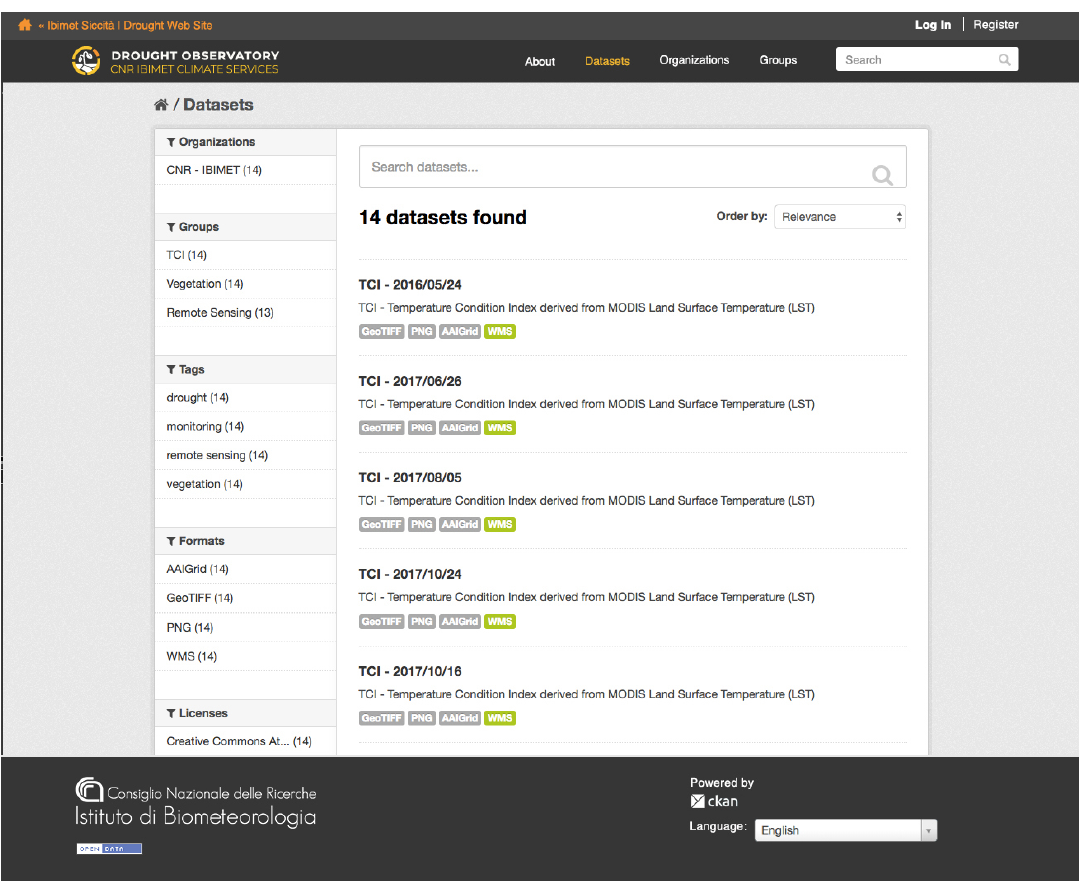
Figure 8. Data catalog implemented by CKAN (Comprehensive Knowledge Archive Network) data-management platform for the IBIMET–CNR Drought Climate